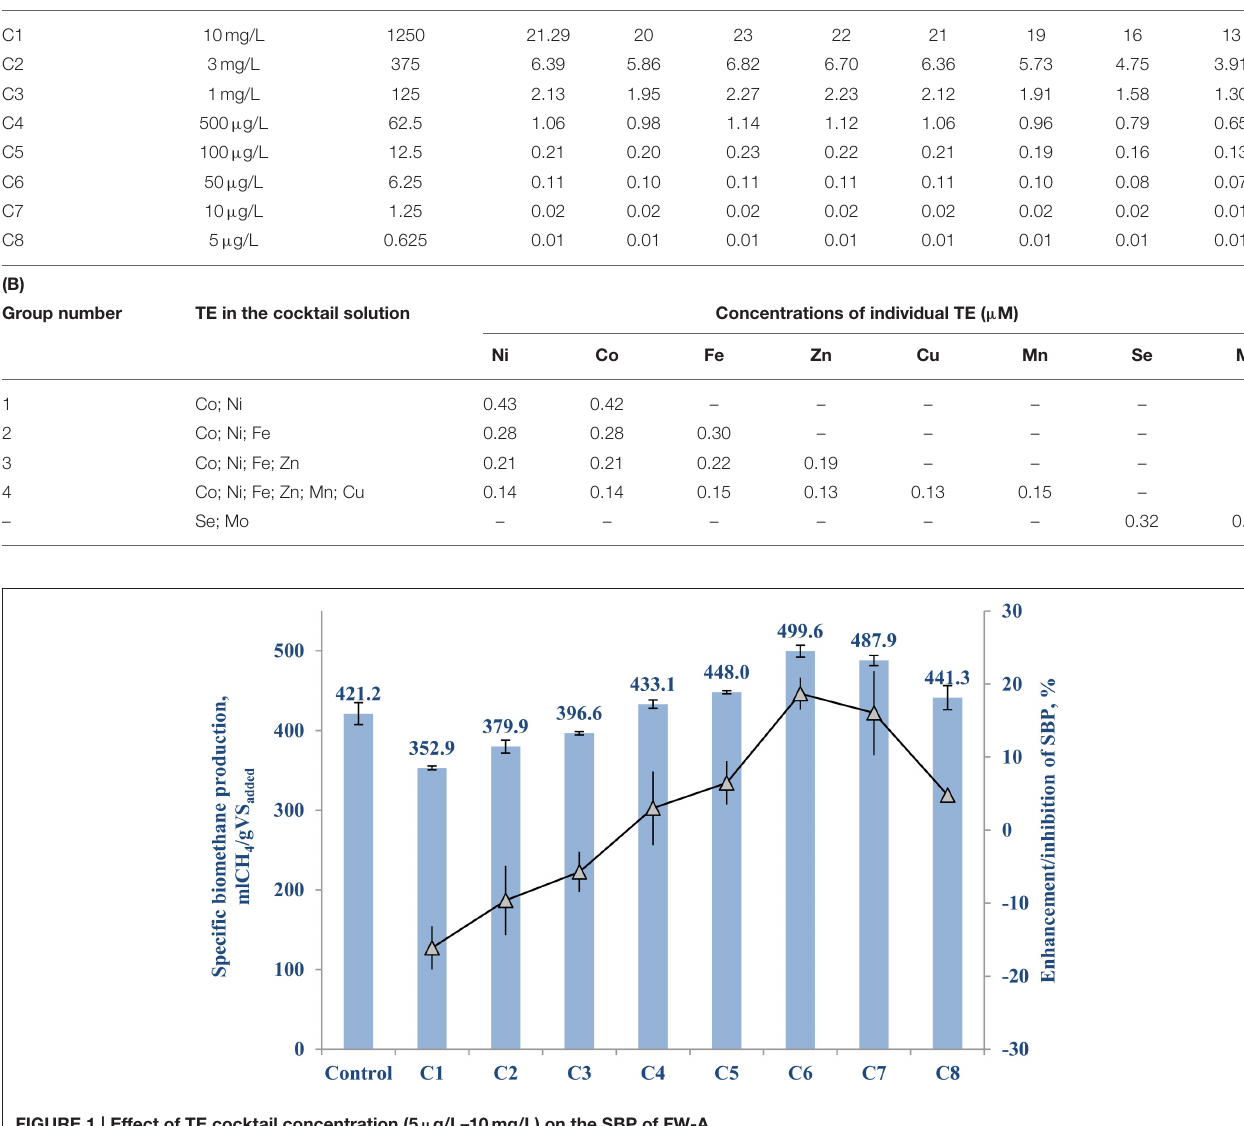
FIGURE 1 | Effect of TE cocktail concentration (5 µ g/L–10mg/L) on the SBP of